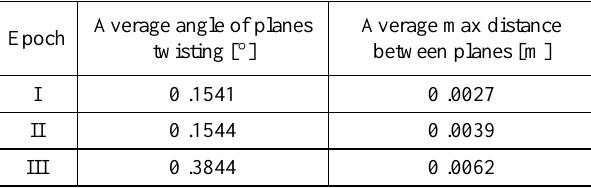
Table 6. The average angle of plane twisting with the average